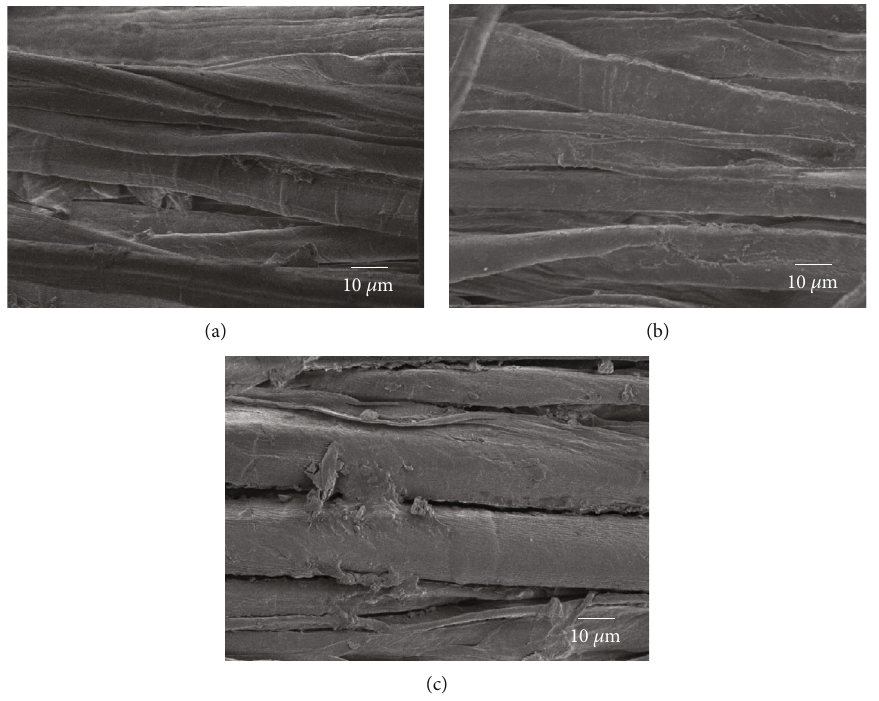
Figure 3: SEM images of (a) untreated, (b) dyed, and (c) antibacterial fi nished fabrics.